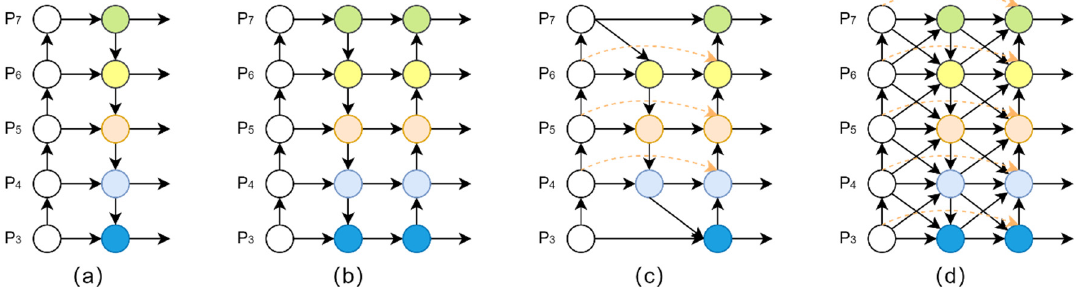
Figure 4. Iterative design of feature pyramid network from level 3 to level 7 (P3-P7). ( a ) FPN proposes a top-down pathway to aggregate multiscale features; ( b ) PANet adds an additional bottom-up pathway based on FPN; ( c ) BiFPN adds a bidirectional cross-scale pathway based on PANet; ( d ) GFPN introduces a queen-fusion pathway and skip-layer connection method based on